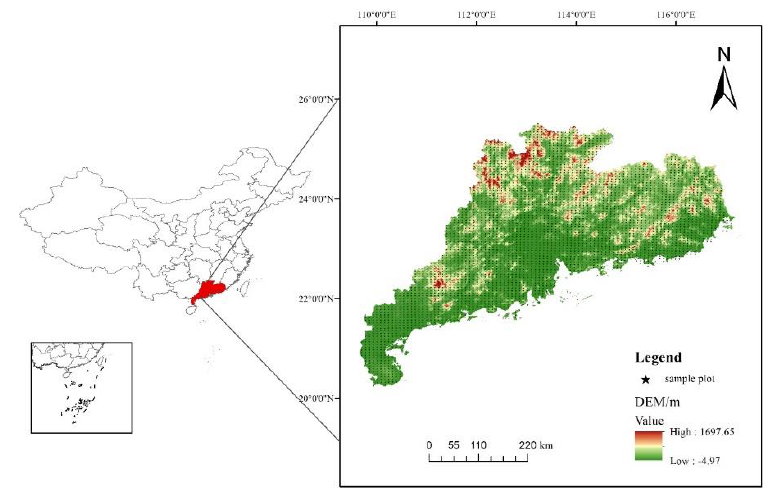
Figure 1. Location of Guangdong Province and sample plots.